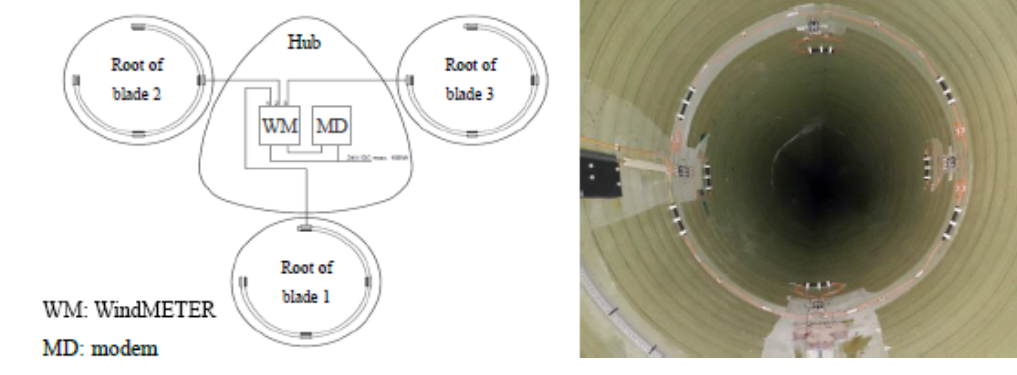
Figure 17. Strain measurement at the blade root: wiring and photo.